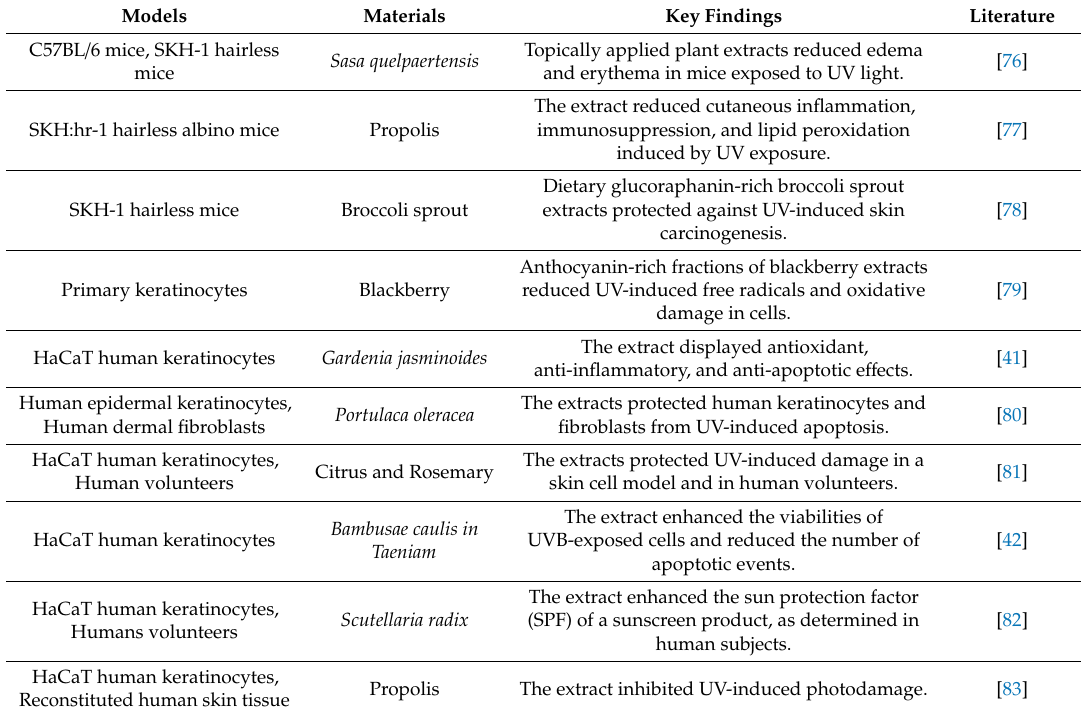
Table 1. Protective e ff ects of plant-derived extracts against ultraviolet (UV) radiation-induced toxicity.